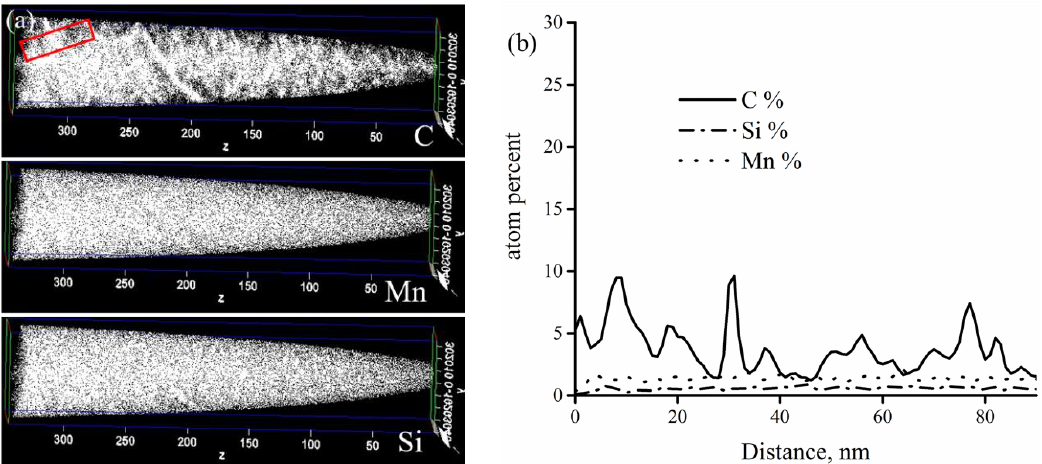
Figure 12. The 3D element maps of an APT needle taken in WEL, ~2 μm beneath the rail surface ( a ) and the composition profiles of regions enclosed in the rectangle in ( a ) is shown in ( b ).